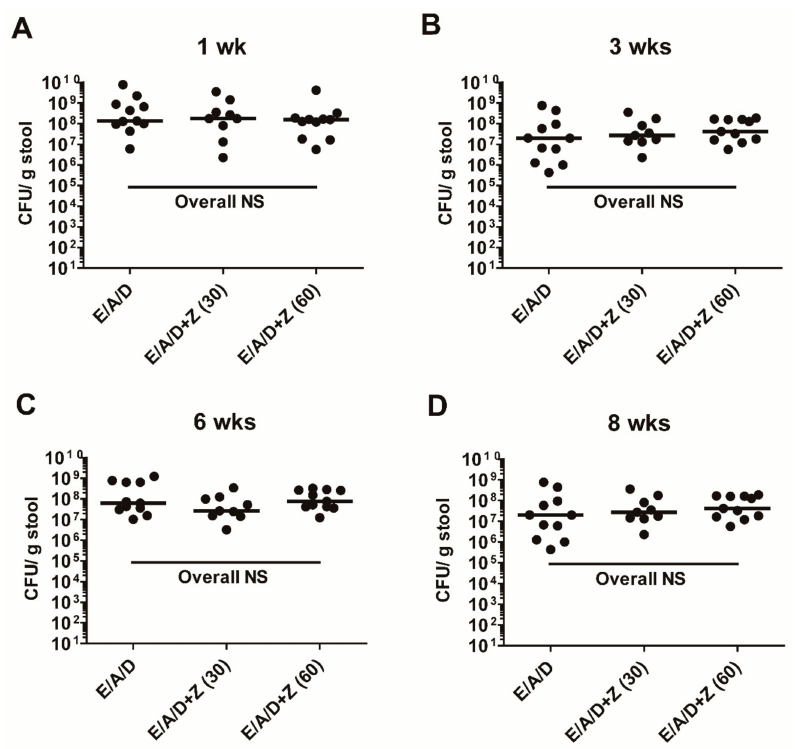
Figure 6. Zerumbone does not a ff ect ETBF colonization in mice. ETBF colonization was assessed by stool plating. Colonization was generally within the range of 10 7 –10 9 CFU / g stool at 1 ( A ), 3 ( B ), 6 ( C ) and 8 ( D ) weeks after ETBF infection. S, sham control; E, ETBF; A, AOM; D, DSS; Z (30), Zerumbone (30 mg / kg); Z (60), Zerumbone (60 mg / kg); CFU, colony-forming units and nd, not detected. Each dot represents one mouse. Scatter plot. Horizontal bar, median. ns, no statistical